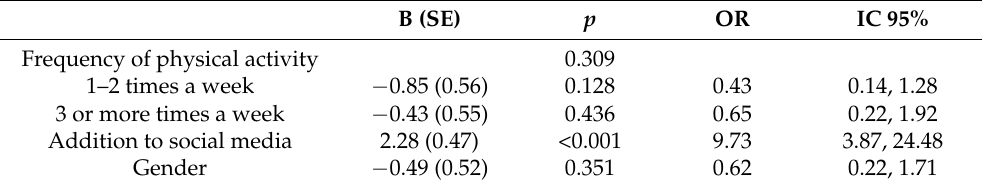
Table 2. Binary logistic regression model for suicidal